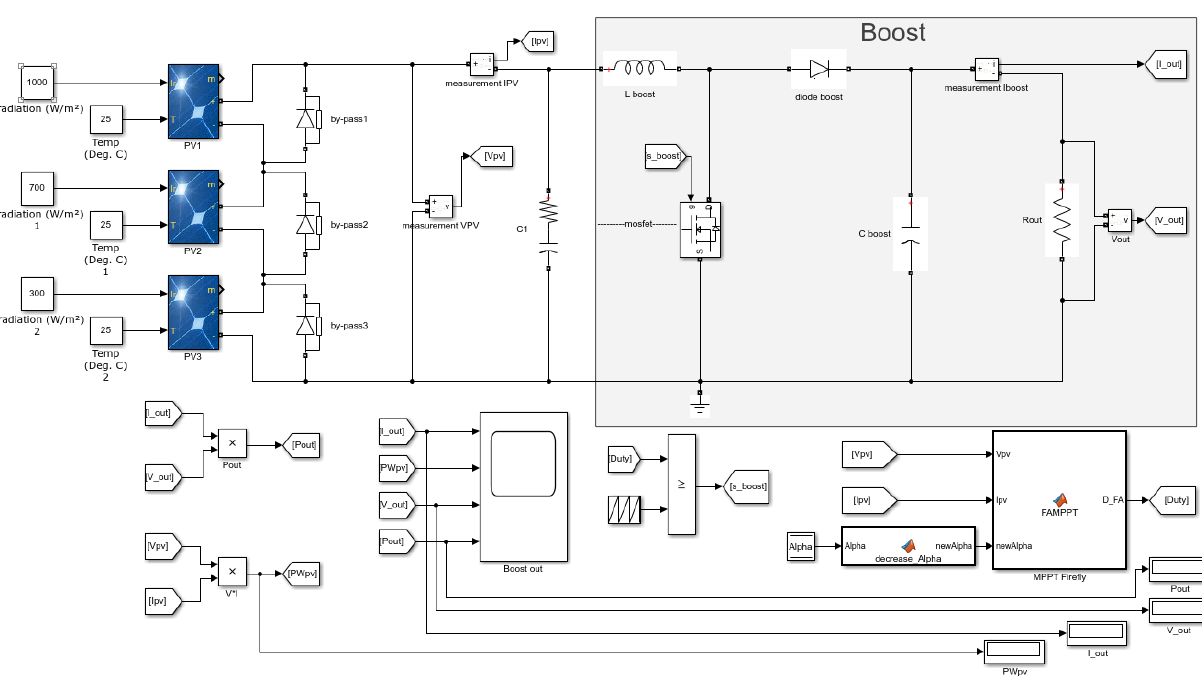
Figure 8. Circuit model implemented in